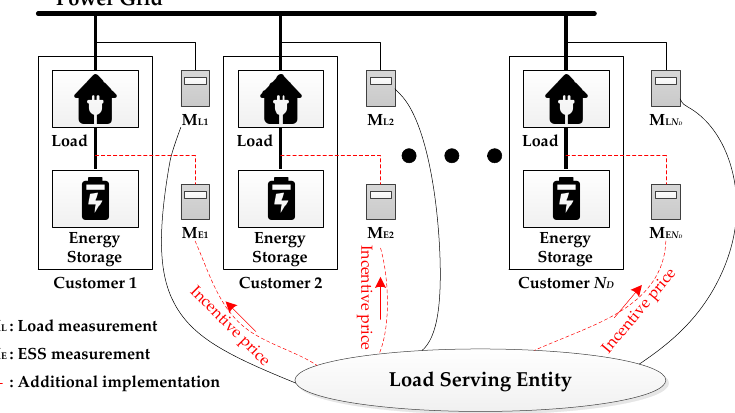
Figure 1. System model for the proposed indirect load control (ILC). ESS: energy storage system.